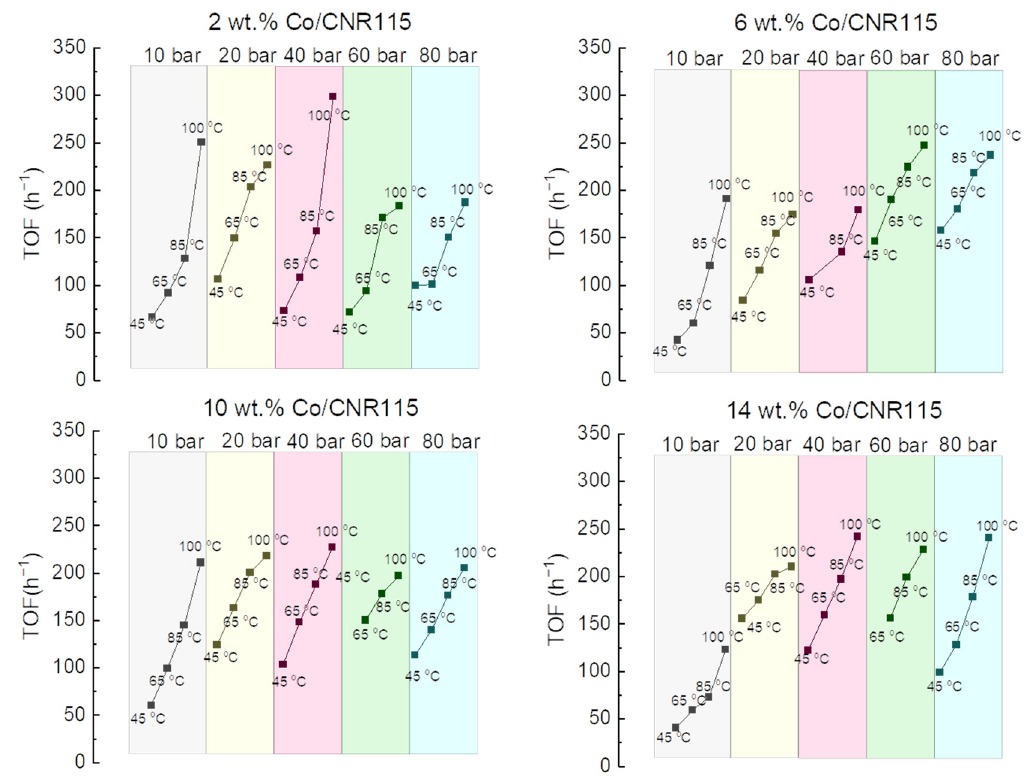
Figure 5. Turnover frequency for 2, 6, 10 and 14 wt.% Co/CNR115 at different values of pressure and temperature.